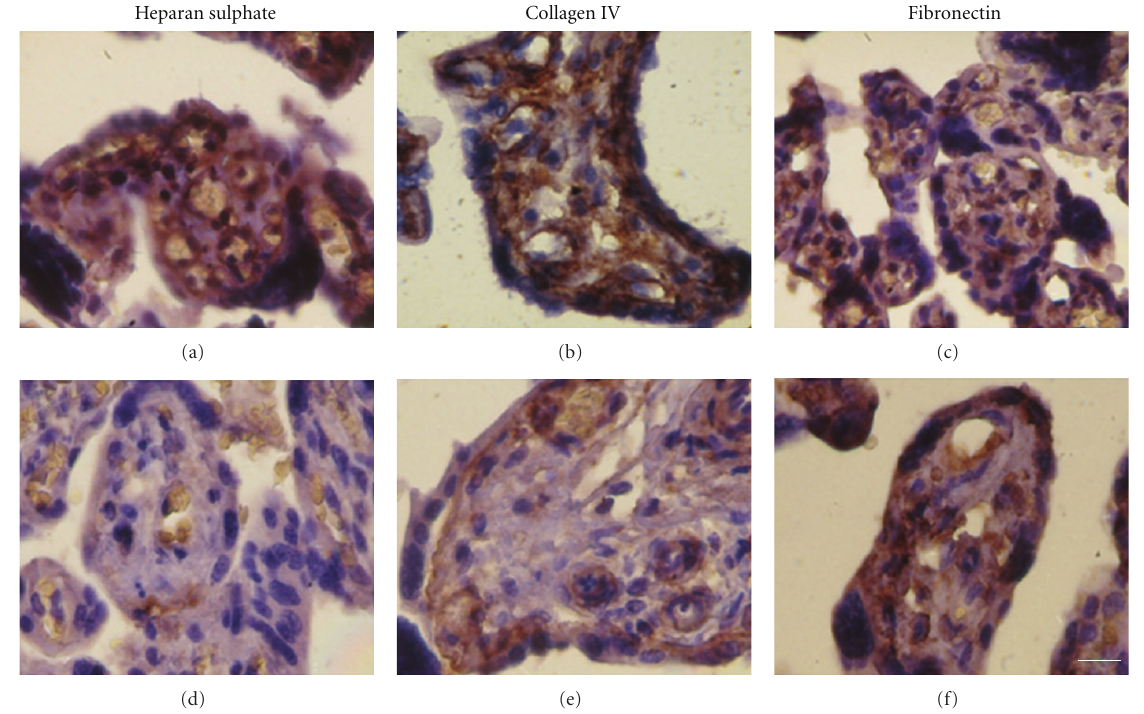
Figure 5: Placentas from mothers infected with T. cruzi present selective basal lamina disorganization in chorionic villi . Placental tissue from control non-infected (a–c) and infected (d–f) women were immunostained for heparan sulphate (a, d), collagen IV (b, e), and fibronectin (c, f). Placental chorionic villi from infected mothers completely lost their immunoreactivity for heparan sulphate (d) and showed reduced immunoreactivity for collagen IV (e), compared to controls (a, b). No di ff erence in immunoreactivity for fibronectin was observed between controls and infected chorionic villi (c, f). Chorionic villi were processed for routine immunohistological techniques and counterstained with Mayer’s hematoxylin. Bar scale: 20 μ